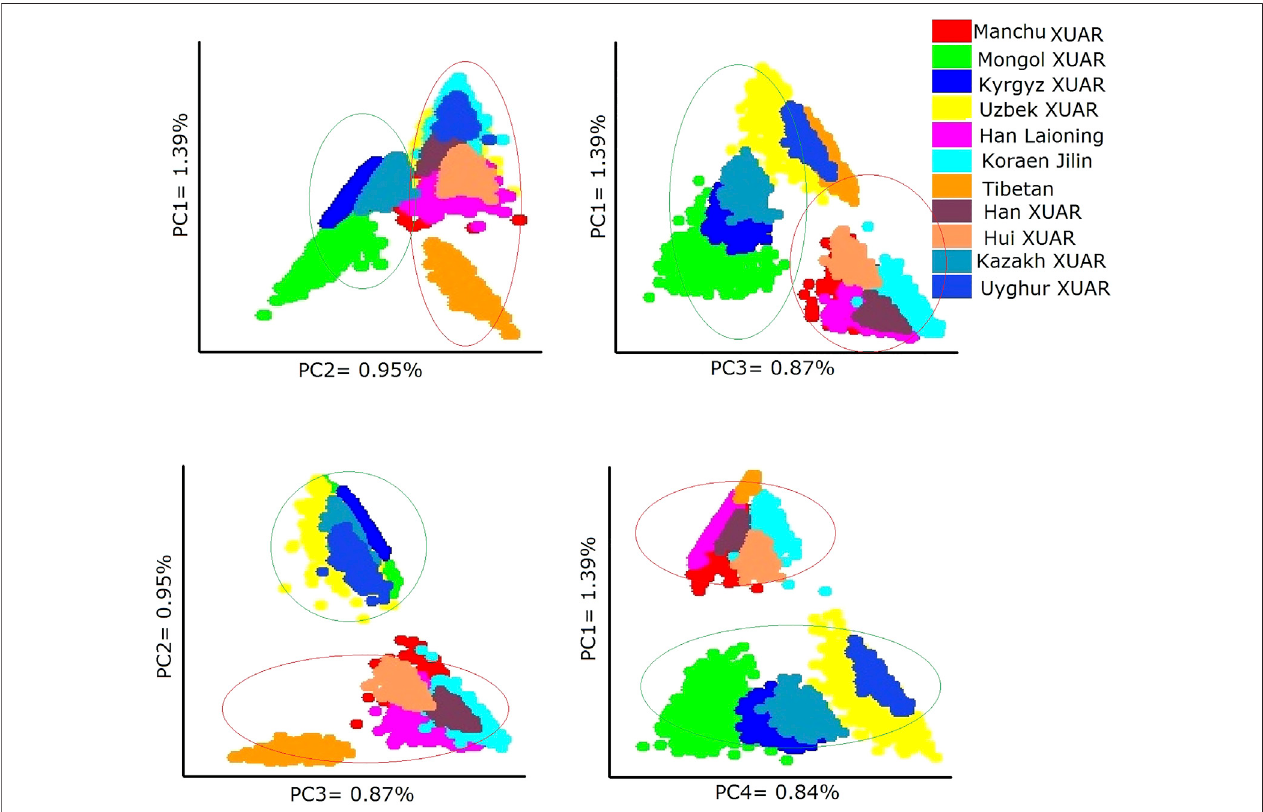
FIGURE2 | Principal component analysis(PCA) revealed the genetic relationship on the basisofthe fi rst four components between Xinjiang Han, Uyghur, Kazakh, Hui, Manchu, Kyrgyz, Uzbek, Mongol, and other Chinese populations.